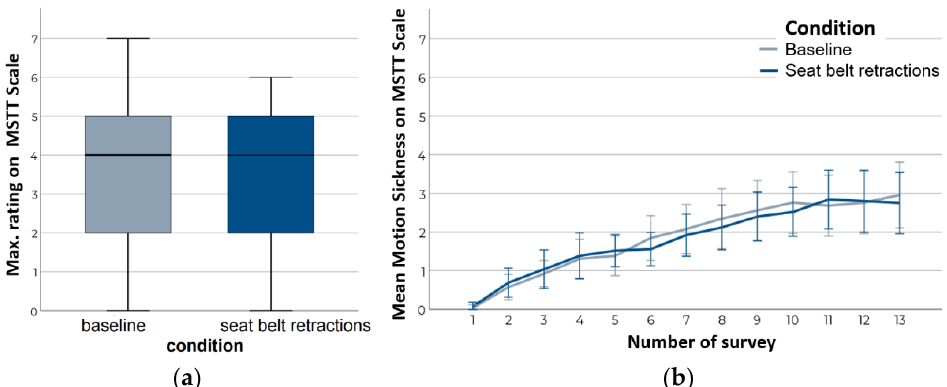
Figure 8. Illustration of ratings on the MSTT scale: ( a ) Distribution of the maximum ratings on the MSTT scale in the baseline and with seat belt retractions; ( b ) Progression of motion sickness rating across the ride.